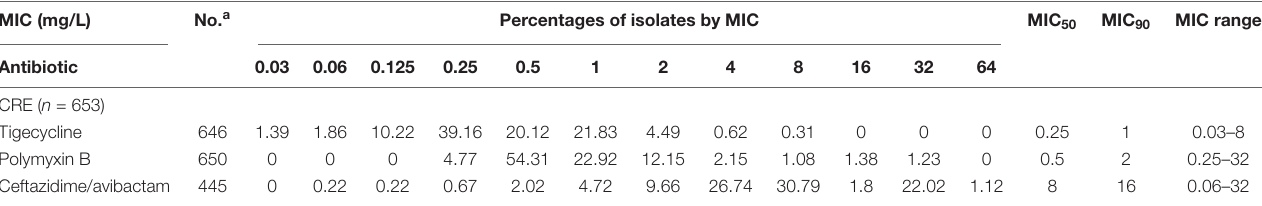
TABLE 4 | MIC distributions for antimicrobials against all CRE isolated from blood specimens in China during 2018–2019. MIC (mg/L) No. a Percentages of isolates by MIC MIC 50 MIC 90 MIC range